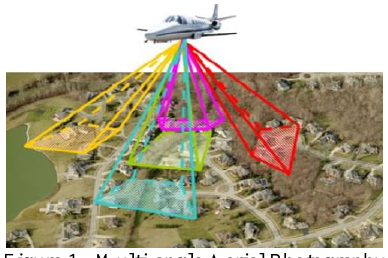
Figure 1. Multi-angle Aerial